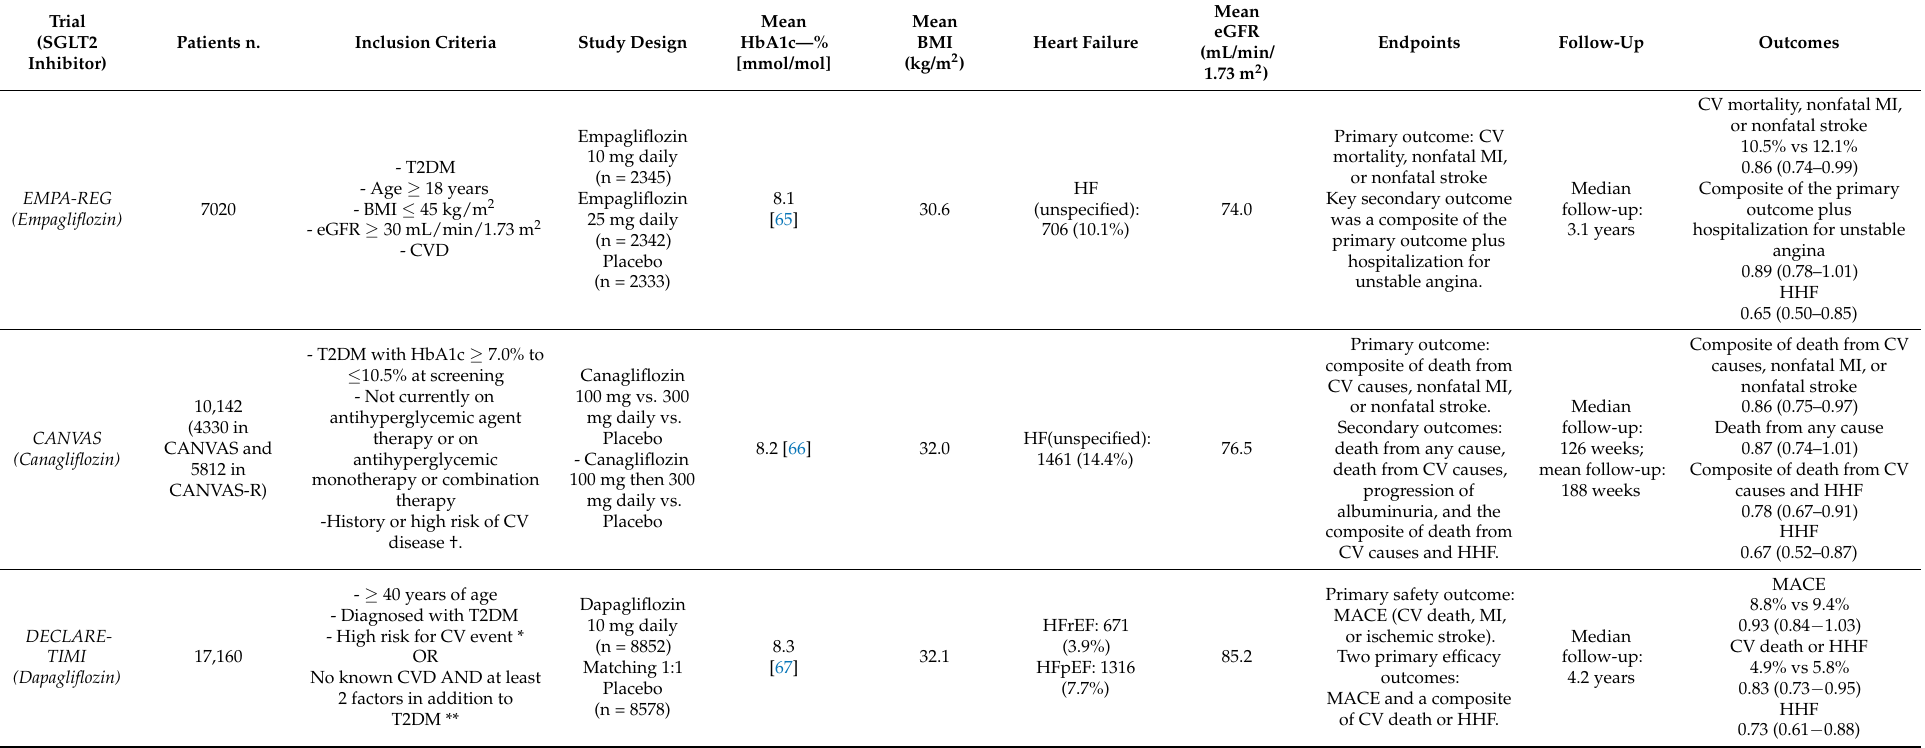
Table 1. BMI: Body Mass Index. CVD: Cardiovascular Disease. eGFR: Estimated Glomerular Filtration Rate. HF: Heart Failure. HHF: Hospitalization for Heart Failure. HFrEF: Heart Failure with reduced Ejection Fraction. HFpEF: Heart Failure with preserved Ejection Fraction. MACE: Major Adverse Cardiovascular Events. NYHA: New York Heart Association. T2DM: Type 2 Diabetes Mellitus. MI: myocardial infarction. † Two or more of the following risk factors for cardiovascular disease: duration of diabetes of at least 10 years, systolic blood pressure higher than 140 mmHg while they were receiving one or more antihypertensive agent, current smoking, microalbuminuria or macroalbuminuria or high-density lipoprotein (HDL) cholesterol level of less than 1 mmol per liter (38.7 mg per deciliter). * Defined as clinically evident ischemic heart disease, ischemic cerebrovascular disease or peripheral artery